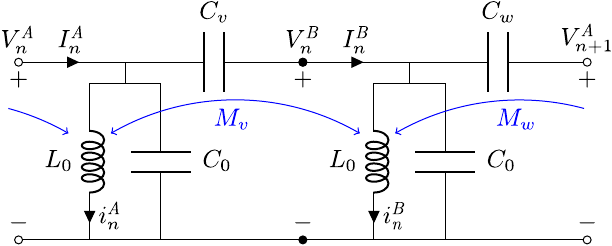
FIG. 5. LC resonators of inductance L 0 and capacitance C 0 are coupled with alternating coupling capacitance C inductance M node A ( B ) are denoted as V A